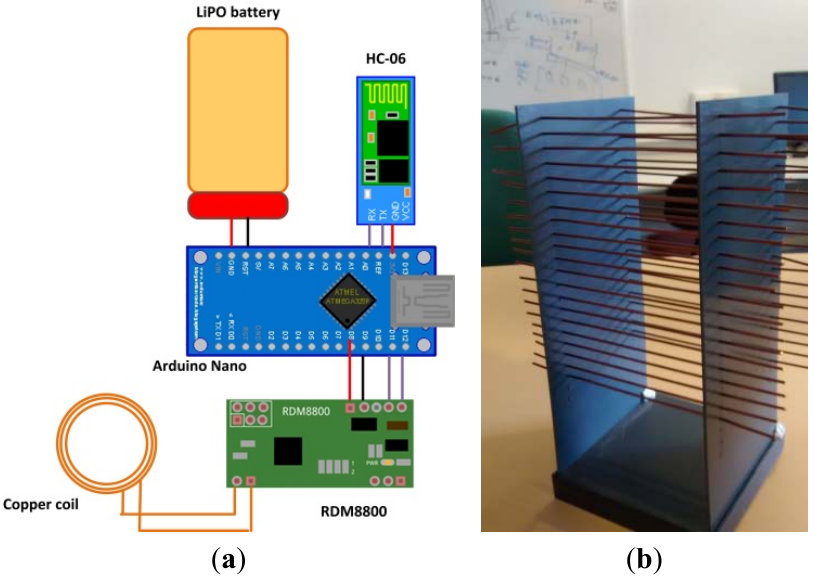
Figure 5. ( a ) Electronic scheme of the cybernetic glove; ( b ) Plastic holder graduated in height for measuring glove